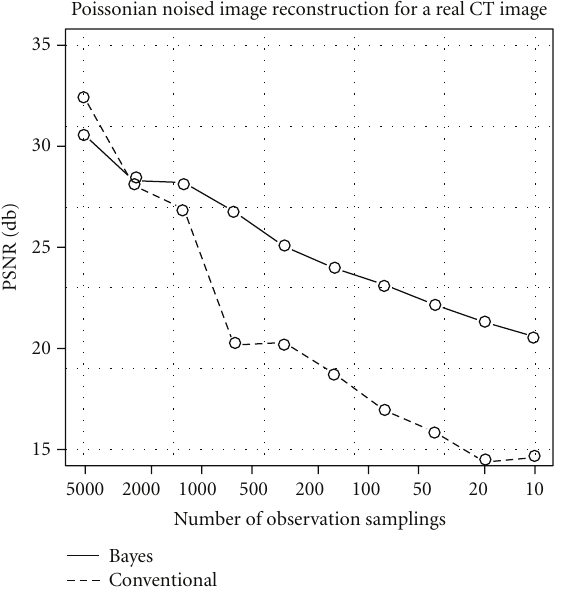
Figure 9: Qualities of reconstruction images measured by PSNR for real CT image reconstruction under the Gaussian noise. The horizontal axis shows the observation SD of Gaussian noise, and the vertical axis shows the PSNR. The solid line shows the result of our Bayesian method, and the dashed one shows that of the conventional FBP method.